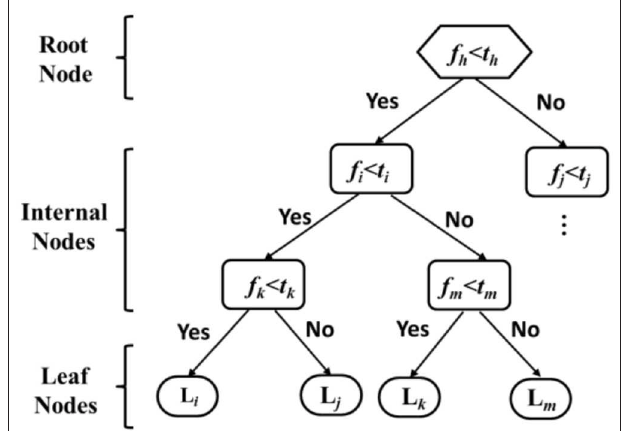
FIGURE 5 | Typical structure of decision